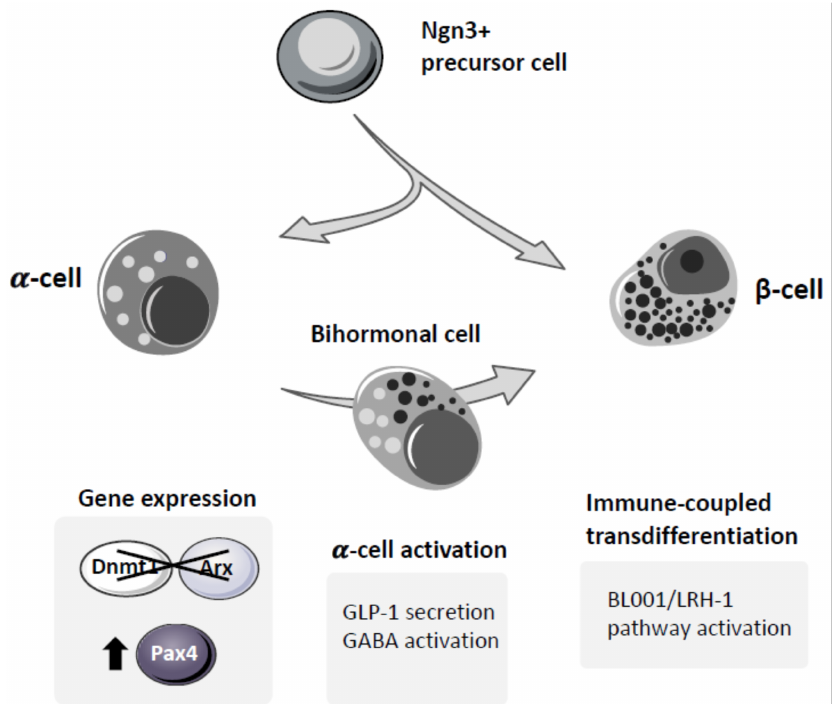
Figure 3. α - to β -cell transdifferentiation. The common origin of α - and β -cells resulted in permissive epigenetic marks in α -cells that under specific circumstances can activate their transdifferentiation into β -cells. This reprogramming of α -cells into β -cells that is activated in islets under stress condi- tions is not able to regenerate an adequate β -cell mass to recover the endogenous control of glycemia. However, this process that involves a close crosstalk between islet cells as well as with the immune system cells can be stimulated by different treatments, such as GLP-1 and likely GABA, as well as the novel small molecule